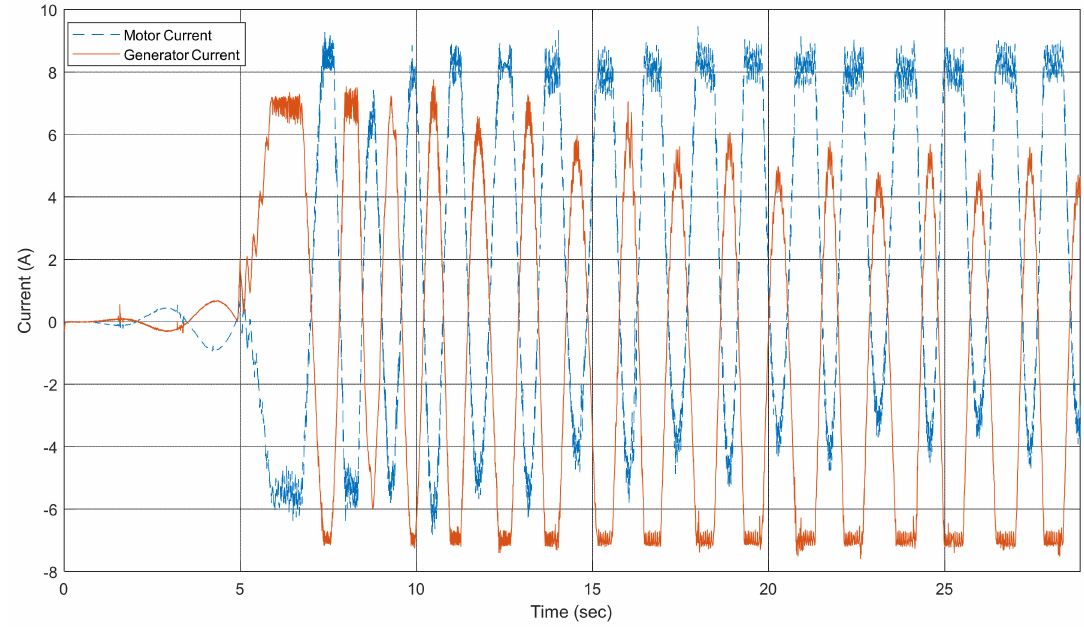
Figure 8. Motor and generator currents for the regular wave case presented in Figure 7a (i.e., crank radius is 2